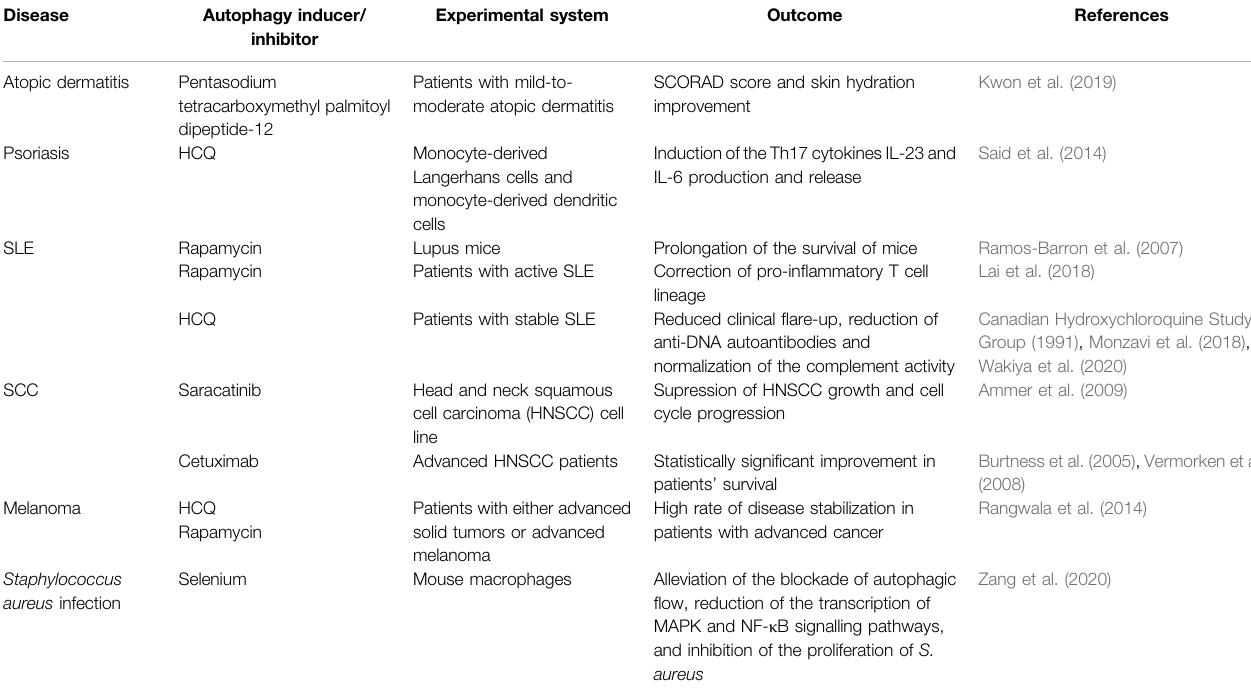
TABLE 1 | Overview of autophagy modulators in skin